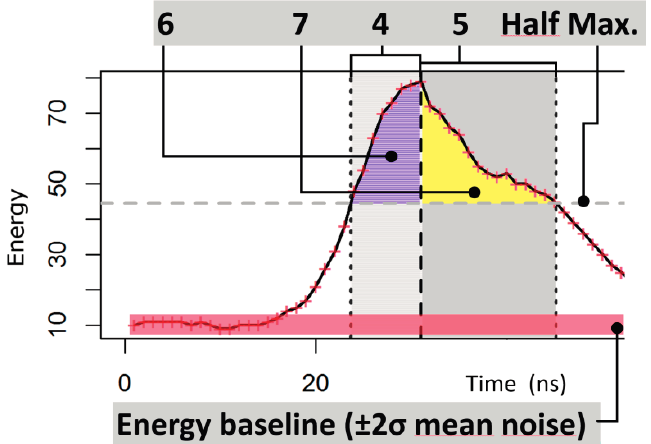
Figure 2. Representation of metrics extracted from full-waveform (FW) data: the numbers refer to Table 2